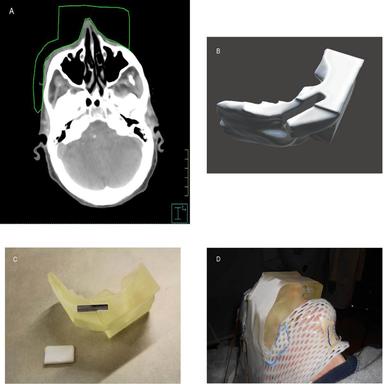
3D bolus RTSTRUCT (A) is converted to an STL file, then remeshed and smoothed (B) prior to final printing (C), and patient use (D). The slot in the bolus material (B) was generated during the remeshing process to accept an integrated stainless steel eye shield (C) to reduce dose to the eye during radiotherapy treatment delivery with electrons. This bolus also incorporates a tissue compensator over the nose. The patient was re-simulated (D) prior to treatment to for verification of bolus conformity and to ca